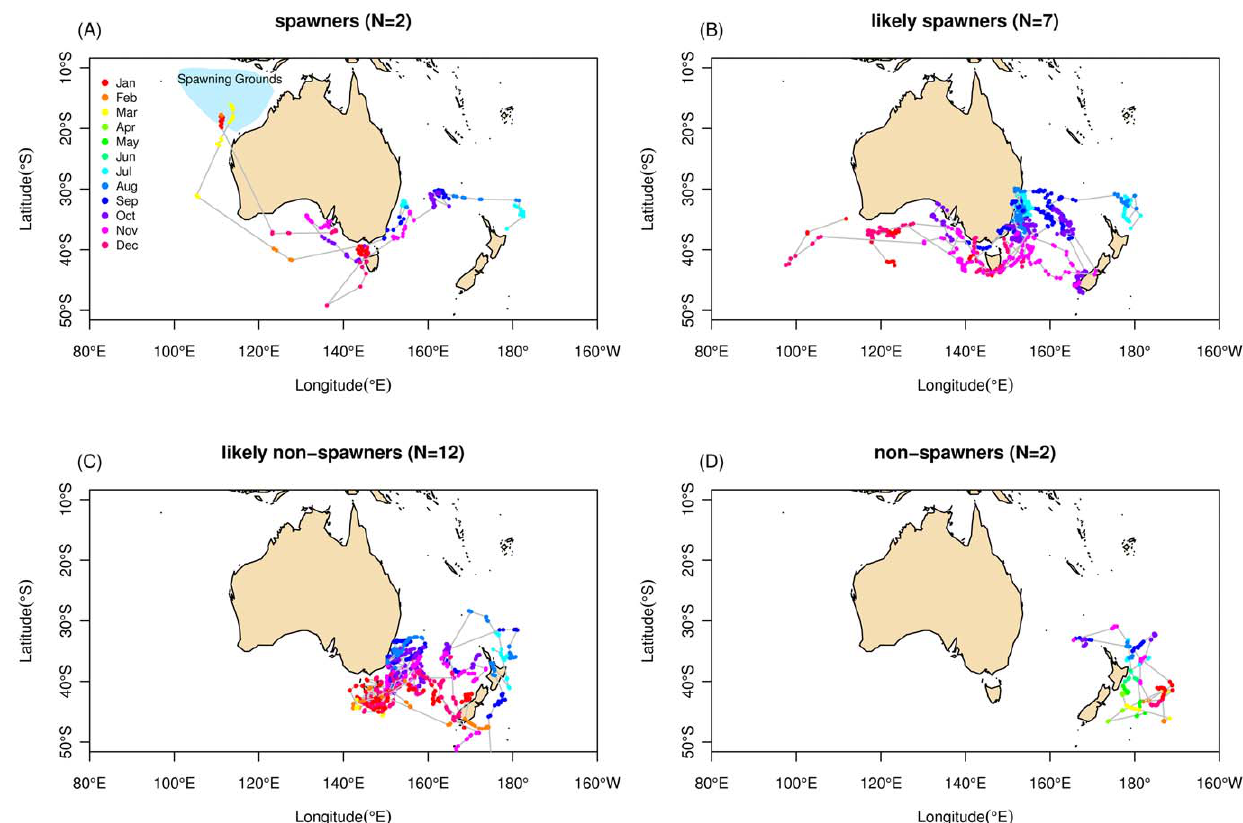
Figure 2. Movement paths of fish categorized by putative spawning behaviour . (a) spawners showing movements from the tagging region to the spawning grounds (defined in blue) (b) likely spawners which made large westward migrations; (c) likely-non spawners remained in the Tasman Sea region until late in the spawning season and (d) non-spawners which remained resident in the Tasman for a full spawning cycle.